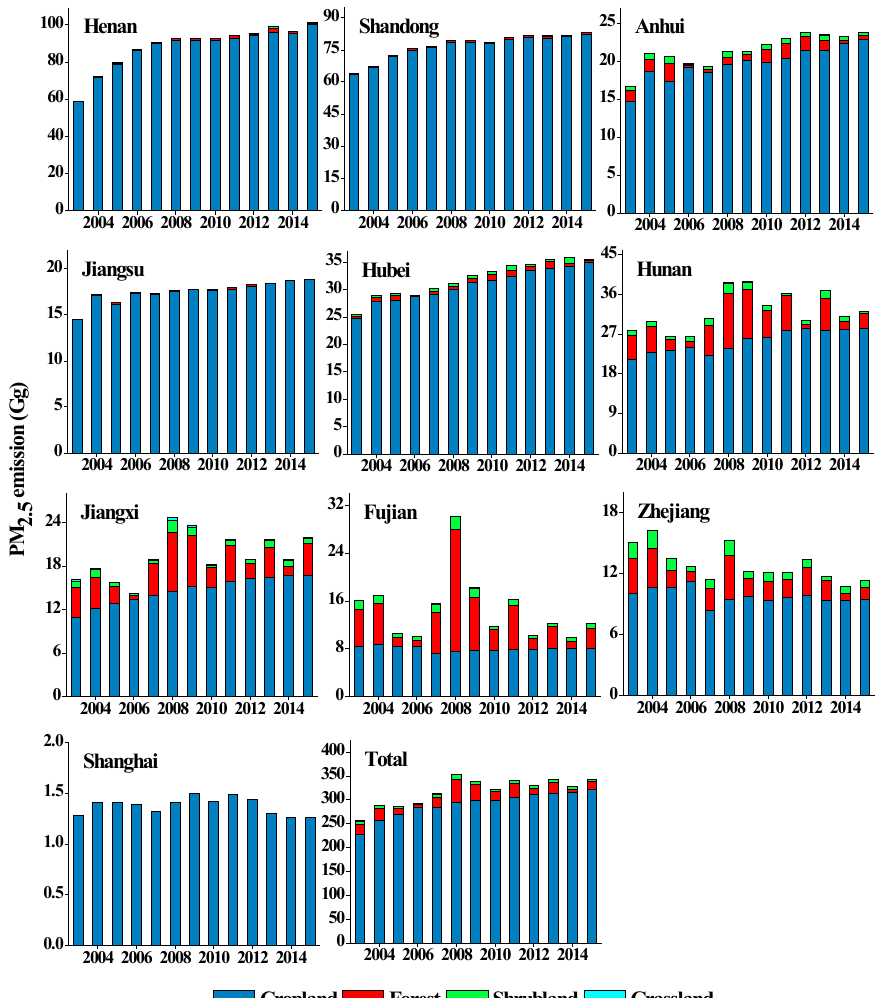
Figure 7. The multi-year PM 2 . 5 emissions of the four types of biomass burning in different provinces from 2003 to 2015.